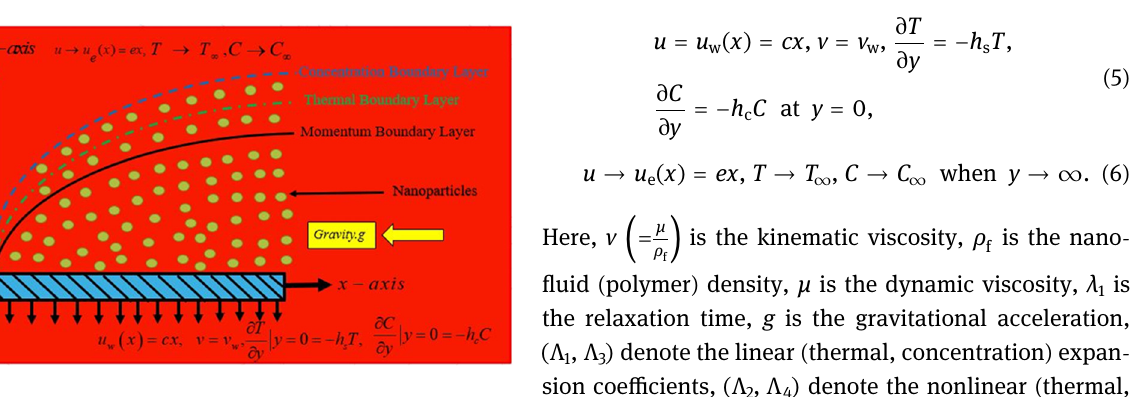
Figure 1: Physical model illustrating the reactive radiative – convec - tive Maxwell nano fl uid stretched fl